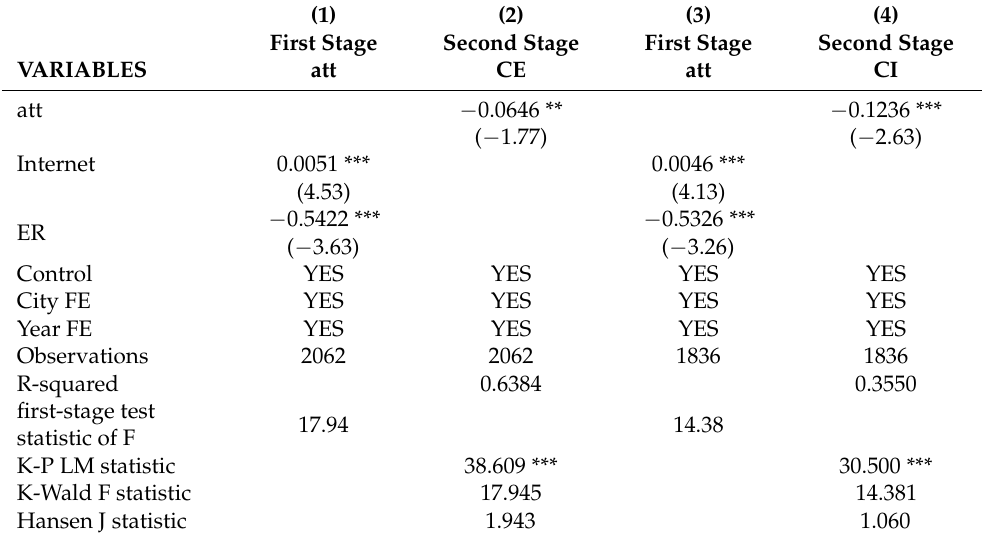
Table 4. Estimation results of the IV